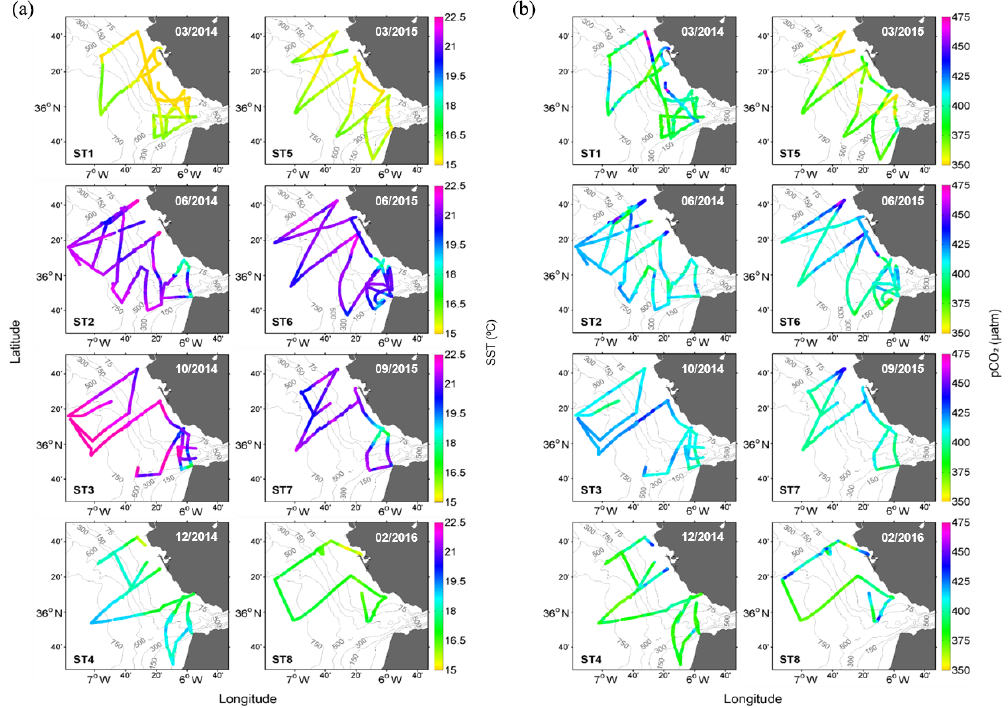
Figure 2. Underway distribution of sea surface temperature (SST ( ◦ C), a ) and p CO 2 (µ atm, b ) during the eight cruises in the Gulf of Cádiz: March 2014 (ST1), June 2014 (ST2), October 2014 (ST3), December 2014 (ST4), March 2015 (ST5), June 2015 (ST6), September 2015 (ST7) and February 2016 (ST8). Table 2. Number of samples ( n ), mean values, and standard deviation for the averaged underway measurements of sea surface temperature (SST), sea surface salinity (SSS), pH, apparent oxygen utilization (AOU), chlorophyll a (data from González-García et al., 2018), and nitrate and phosphate in surface water samples (at depth of 5m) at fixed stations during the eight cruises: March 2014 (ST1), June 2014